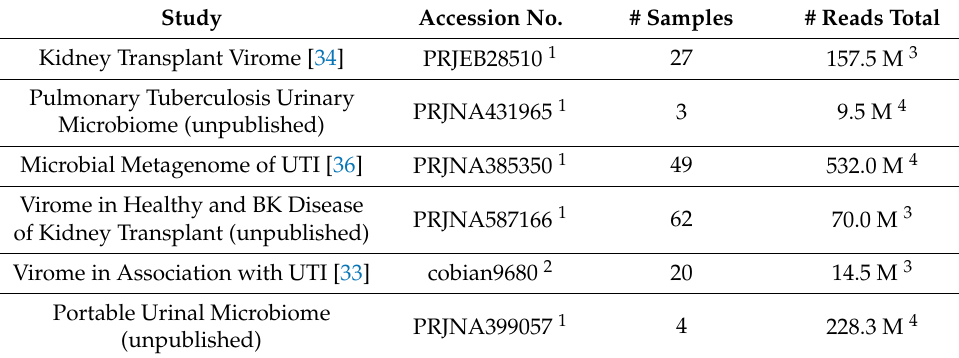
Table 1. Summary of raw read data sets evaluated in this